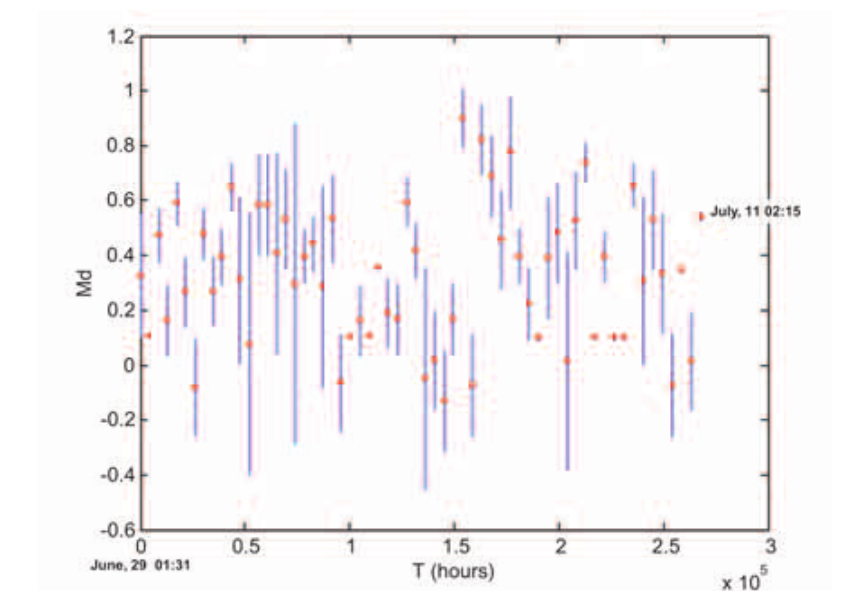
Fig. 7. Temporal evolution of the sequence. The figure indicates only the events recorded by the local network with the maximum